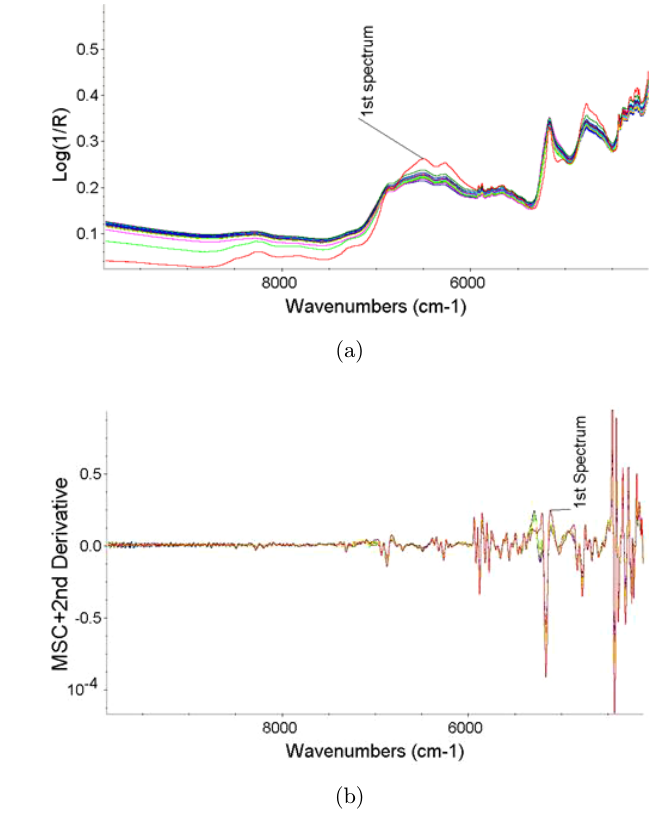
Fig. 1. NIR spectra of coptis and lactose (a) and four di®erent coptis (b).